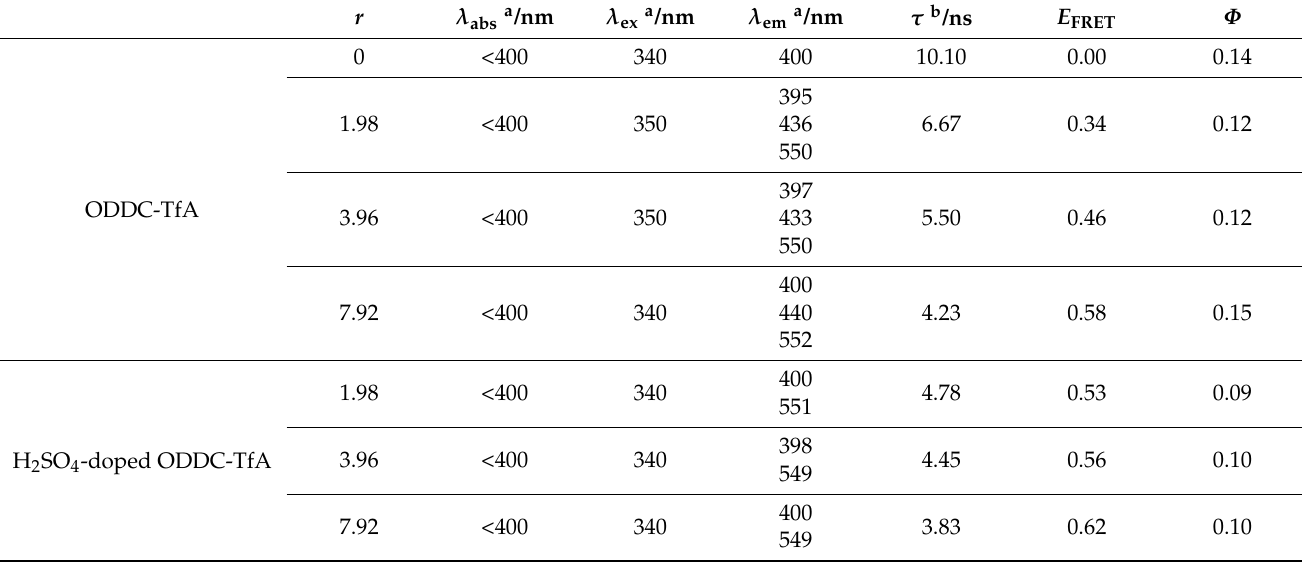
Table 2. Photoluminescence properties, absorption wavelengths ( λ abs ), excitation/emission wavelengths ( λ ex , λ em ), fluorescence lifetimes at 400 nm ( τ ), FRET efficiencies ( E FRET ), and quantum yields ( Φ ) of ODDC and ODDC-TfA doped with 0.5 ~ 1.0 eq. H 2 SO 4 prepared with variable r values ( r = 1.98, 3.96, and